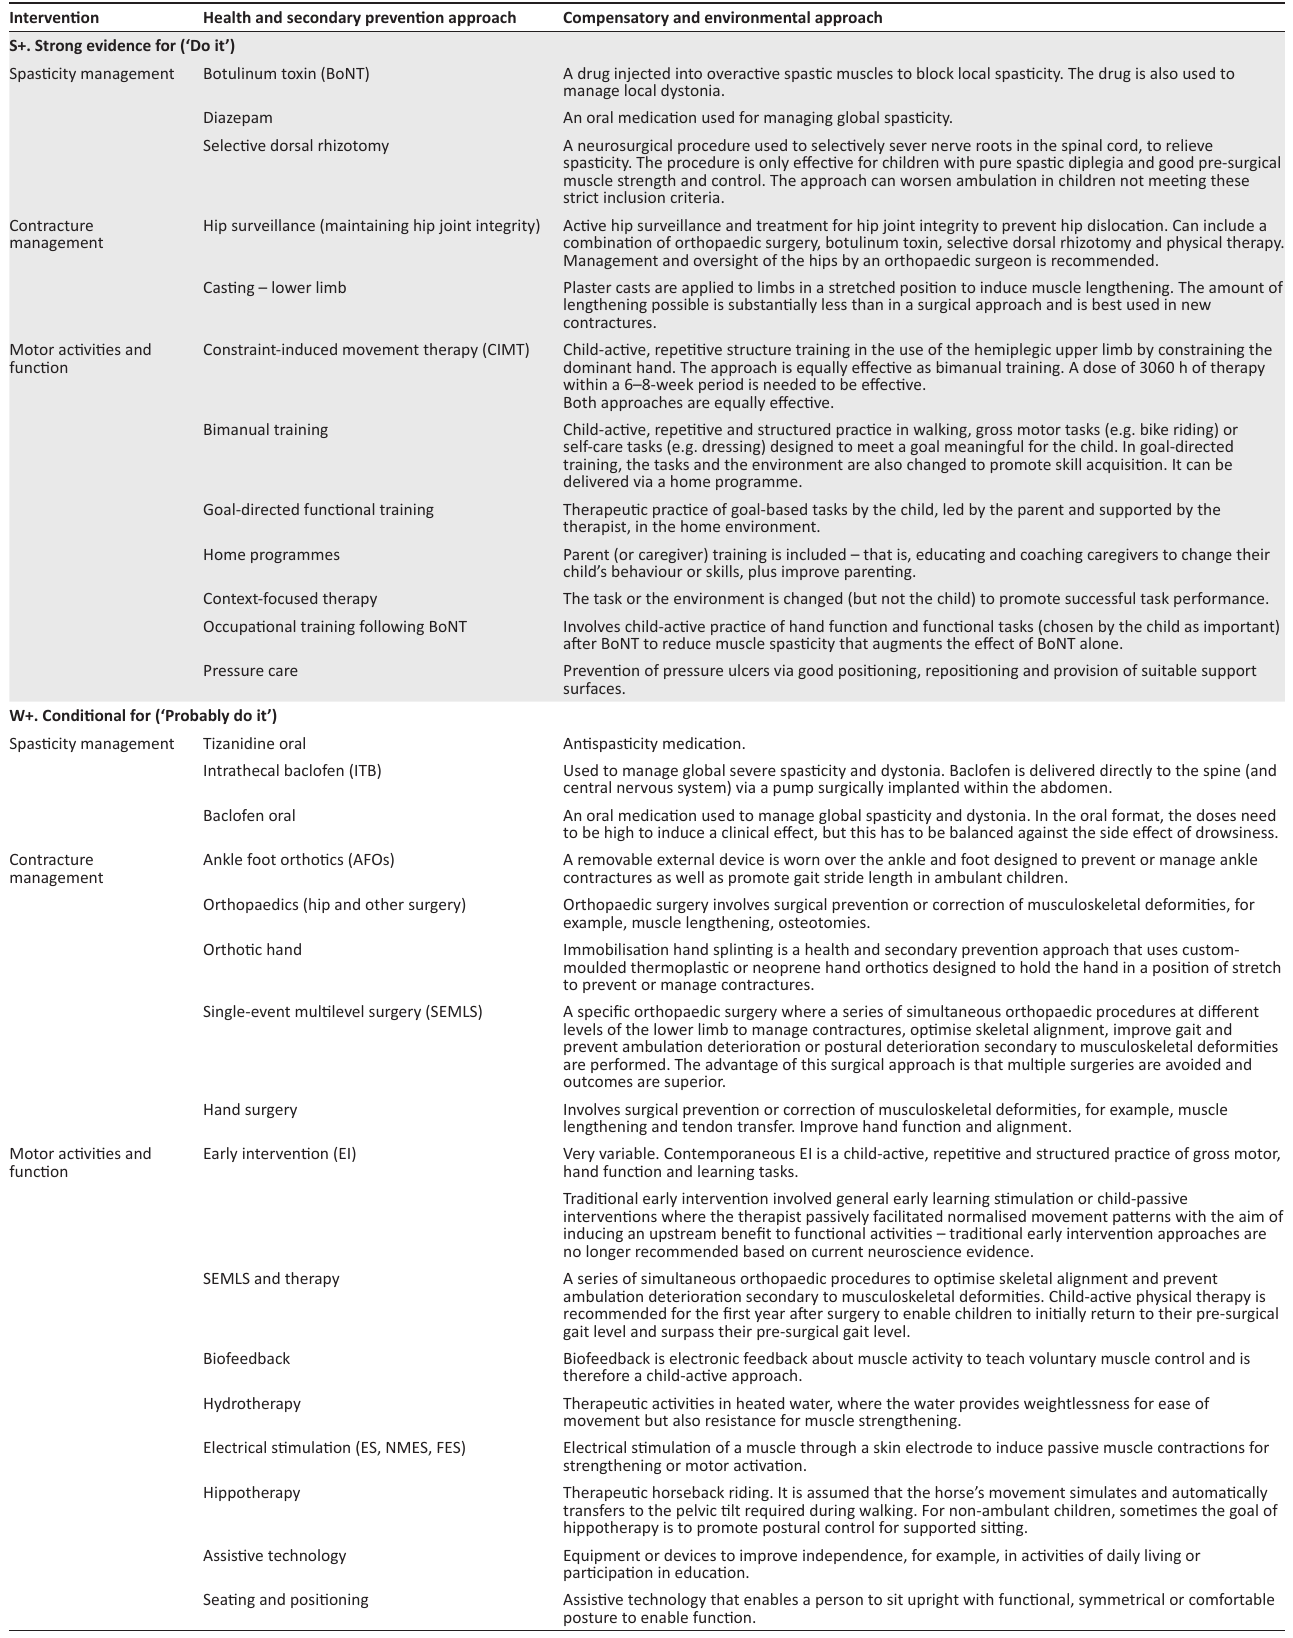
TABLE 1-A1: Levels of evidence (GRADE † ) for intervention options relevant for pain management. Descriptions from Novak et al. (2013:888–897) or Novak (2014:1148–1151).